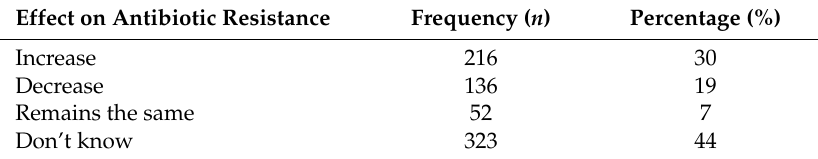
Table 4. Knowledge of the effect of unconventional antibiotic use on antibiotic